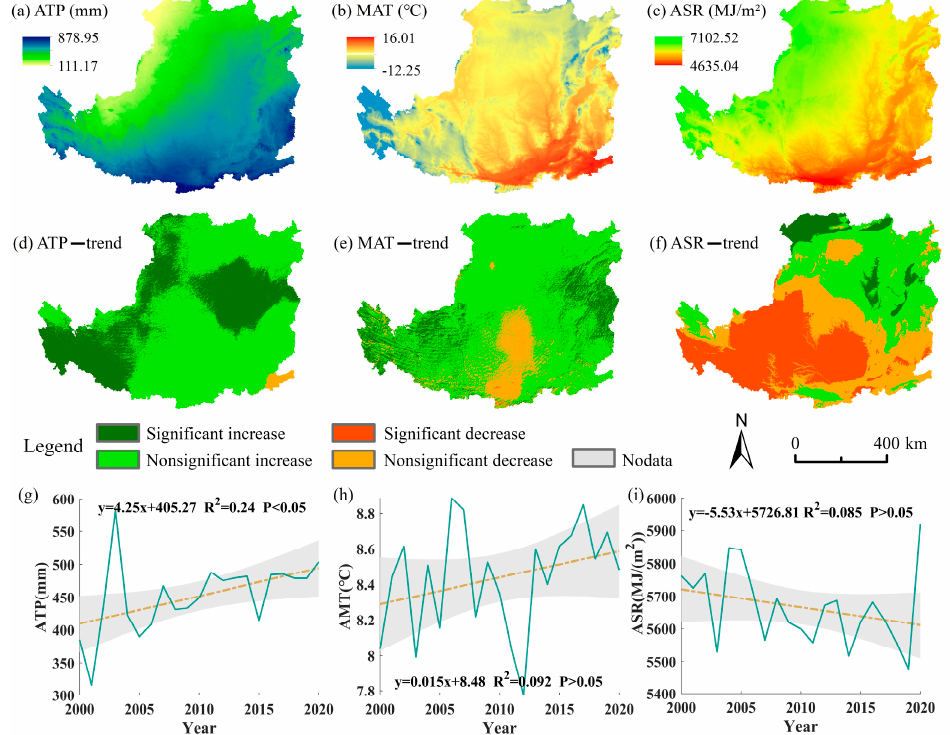
Figure 2. Spatial distributions and temporal variations of climate factors (Note: ( a – c ) are multi-year average spatial distributions of climate factors; ( d – f ) are spatial trends in climate factors; ( g – i ) are annual average trends in climate factors).